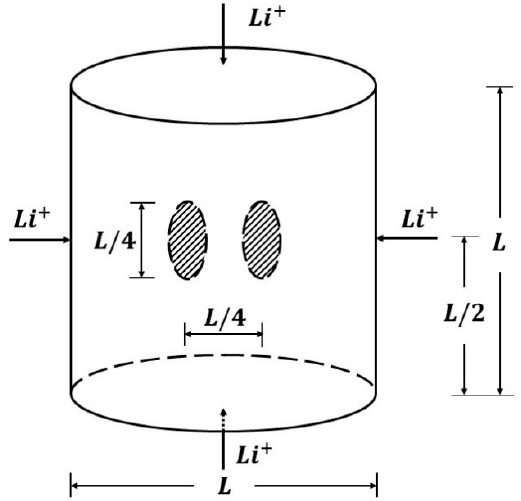
Figure 14. Cylindrical anode structure with pre-existing twin vertical cracks.